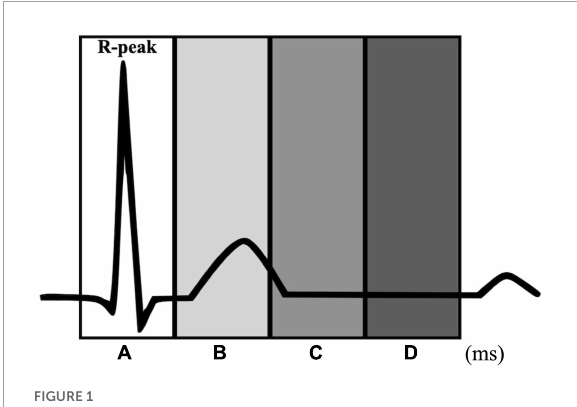
FIGURE1 Time windows for the heartbeat entrainment analyses. Each window is defined relative to the R-peak: –100 to 100 ms (window A), 100 to 300 ms (window B), 300 to 500 ms (window C), and 500 to 700 ms (window